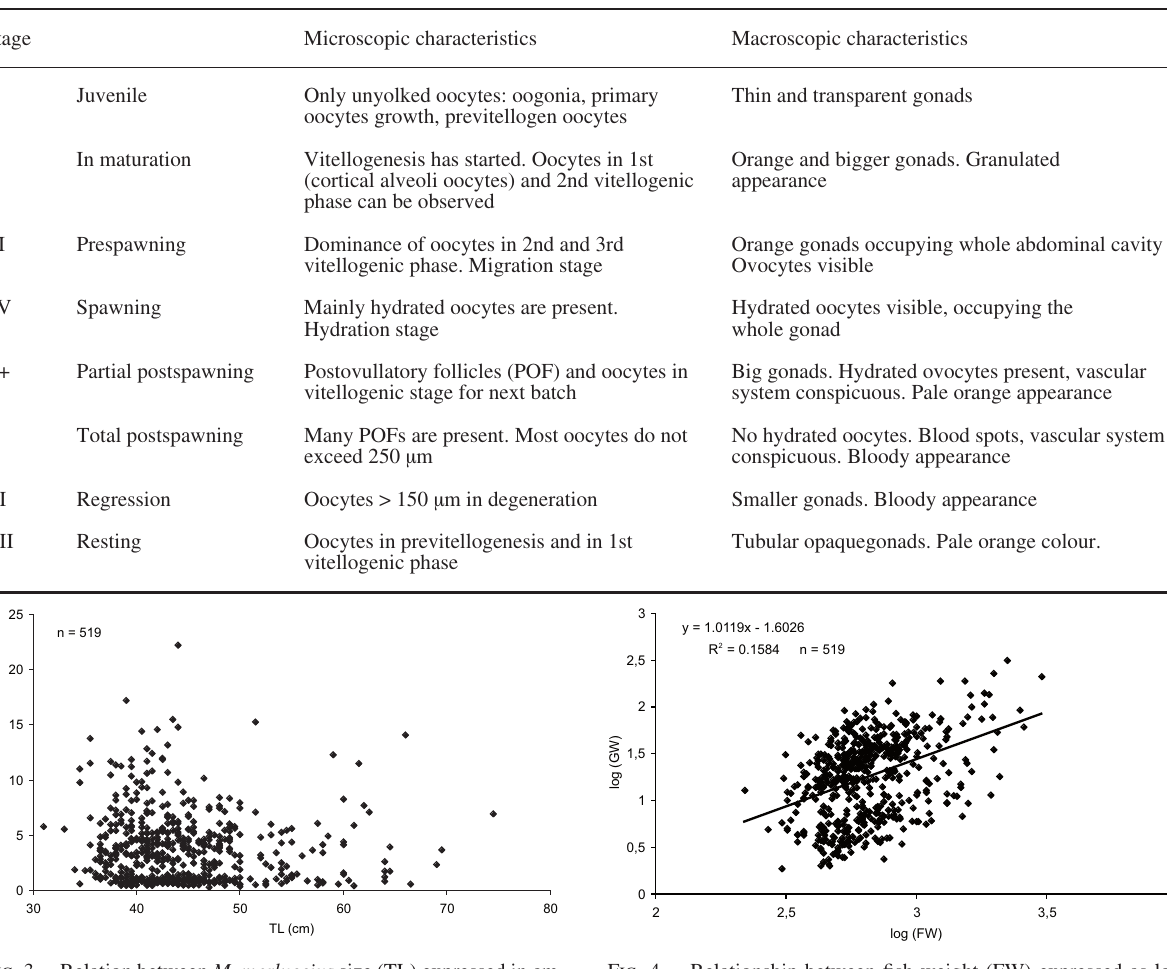
Fig . 4. – Relationship between fish weight (FW) expressed as log Fig . 3. – Relation between M. merluccius size (TL) expressed in cm (FW) and gonad weight (GW) expressed as log (GW). and GSI index.